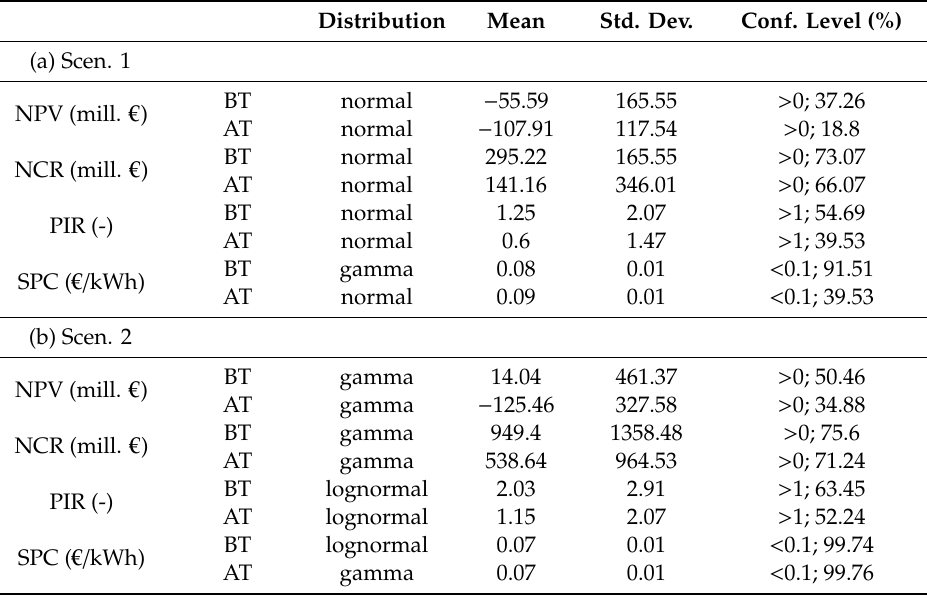
Table 13. Value-at-risk descriptives for Scen. 1 and 2, excl. flooding time. Distribution Mean Std.